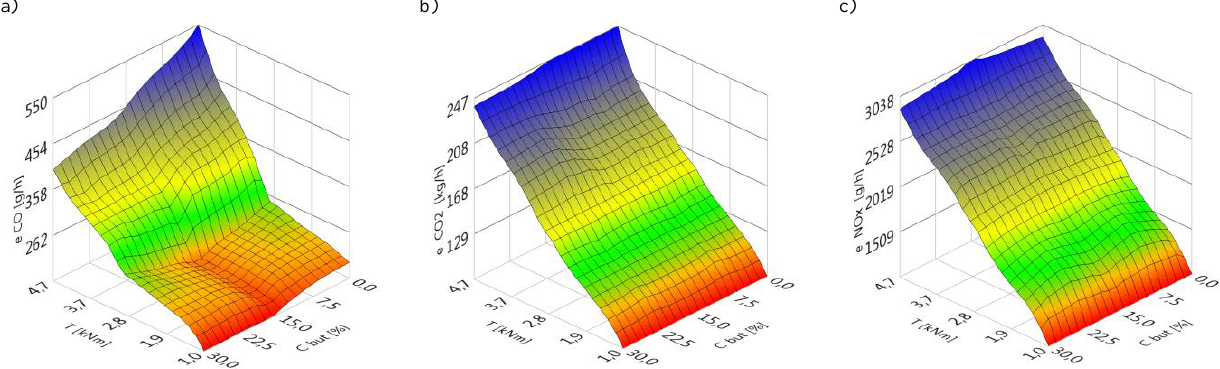
Fig. 9. The surface of emission intensity: a) carbon monoxide, b) carbon dioxide, c) nitrogen oxides at rotation speed n = 750